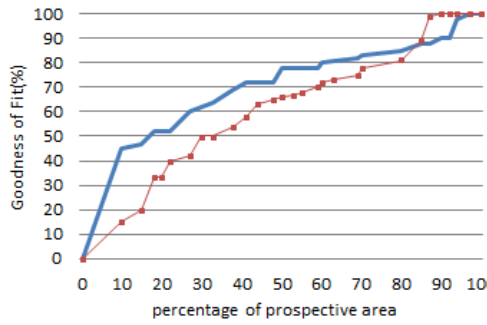
Figure 9. Petroleum potential success and prediction